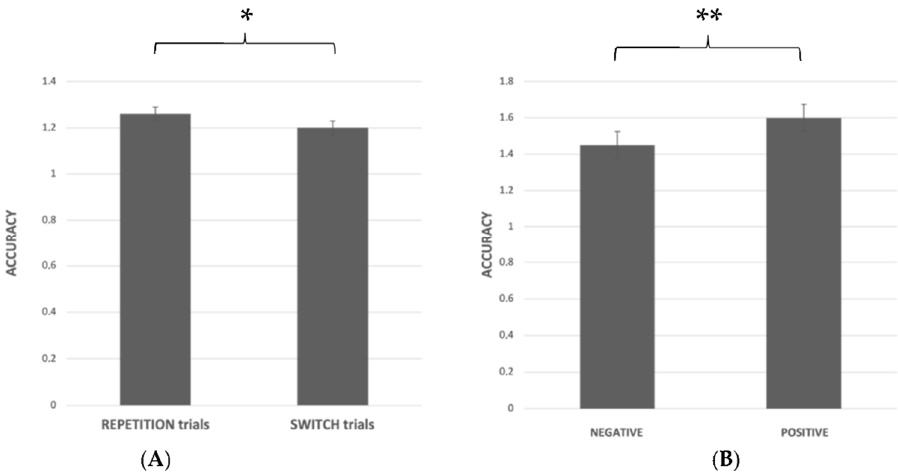
Figure 6. Valence task accuracy in repetition and switch trials ( A ) and in the negative and positive stimuli ( B ); * p < 0.001, ** p < 0.001.